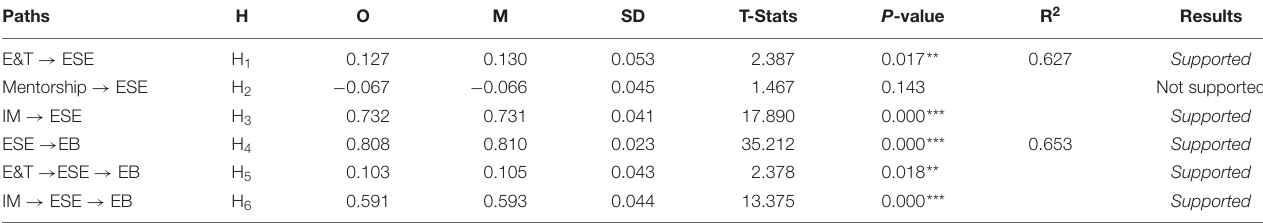
TABLE 5 | Results for structural